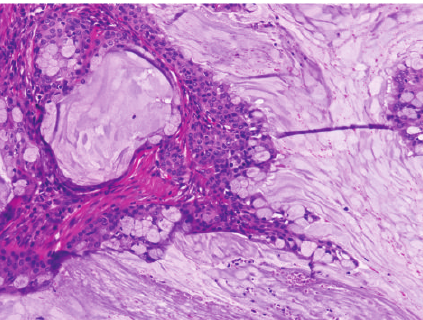
Figure 5: Higher magnification of the tumor shows epidermoid and mucus cells lining the cystic cavities (100x; H&E).